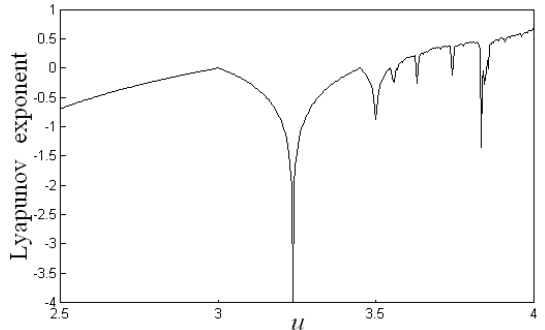
Figure 5. Logistic mapping Lyapunov exponential graph.